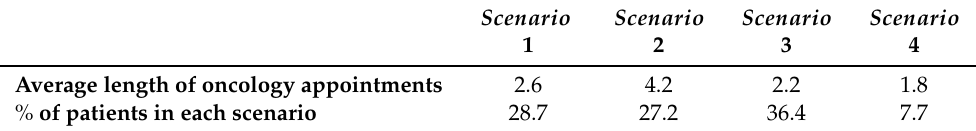
Table 1. New parameters of the problem, which are incorporated into the stochastic